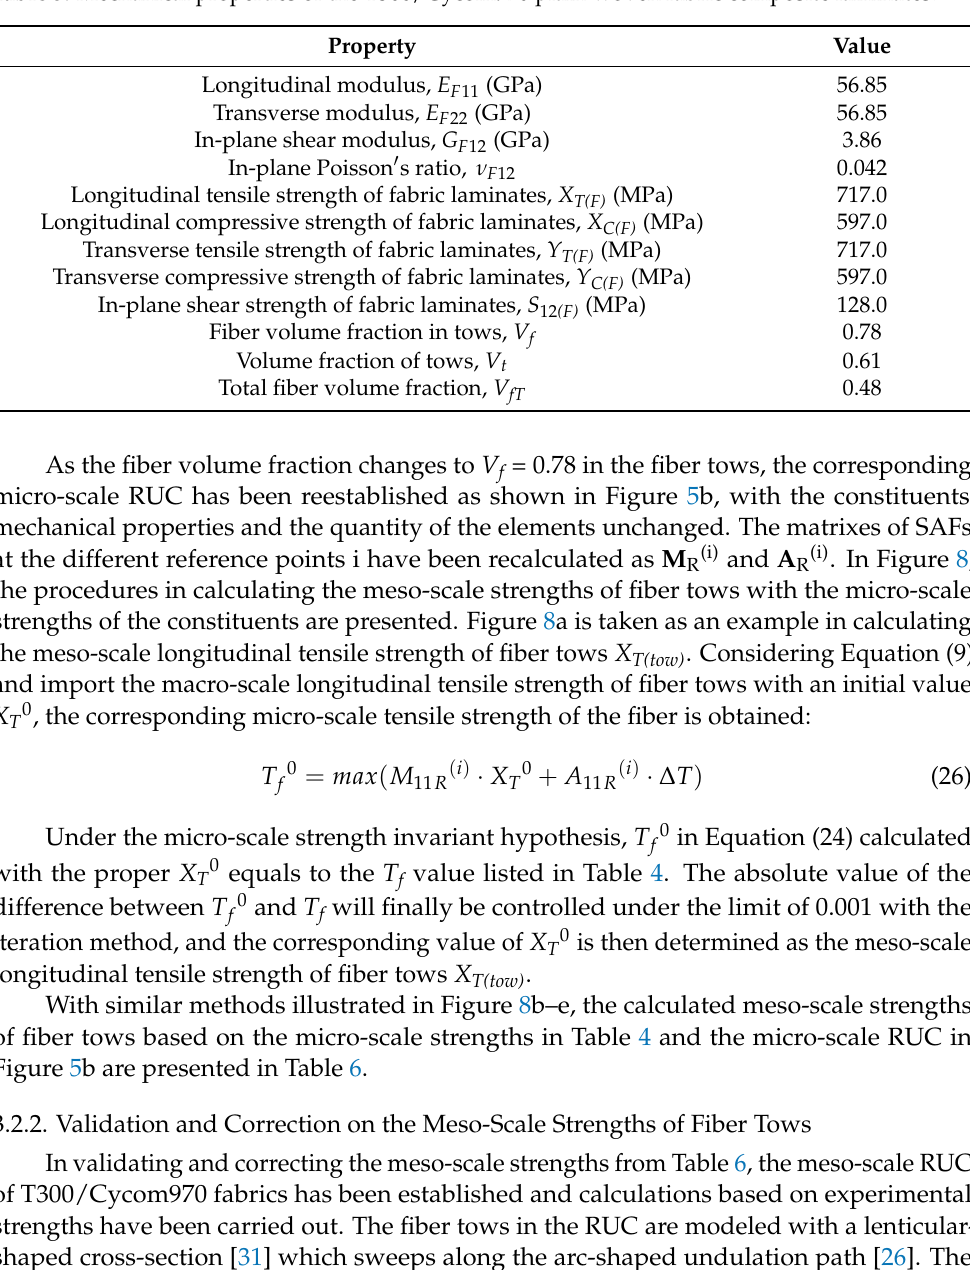
Table 5. Mechanical properties of the T300/Cycom970 plain-woven fabric composite